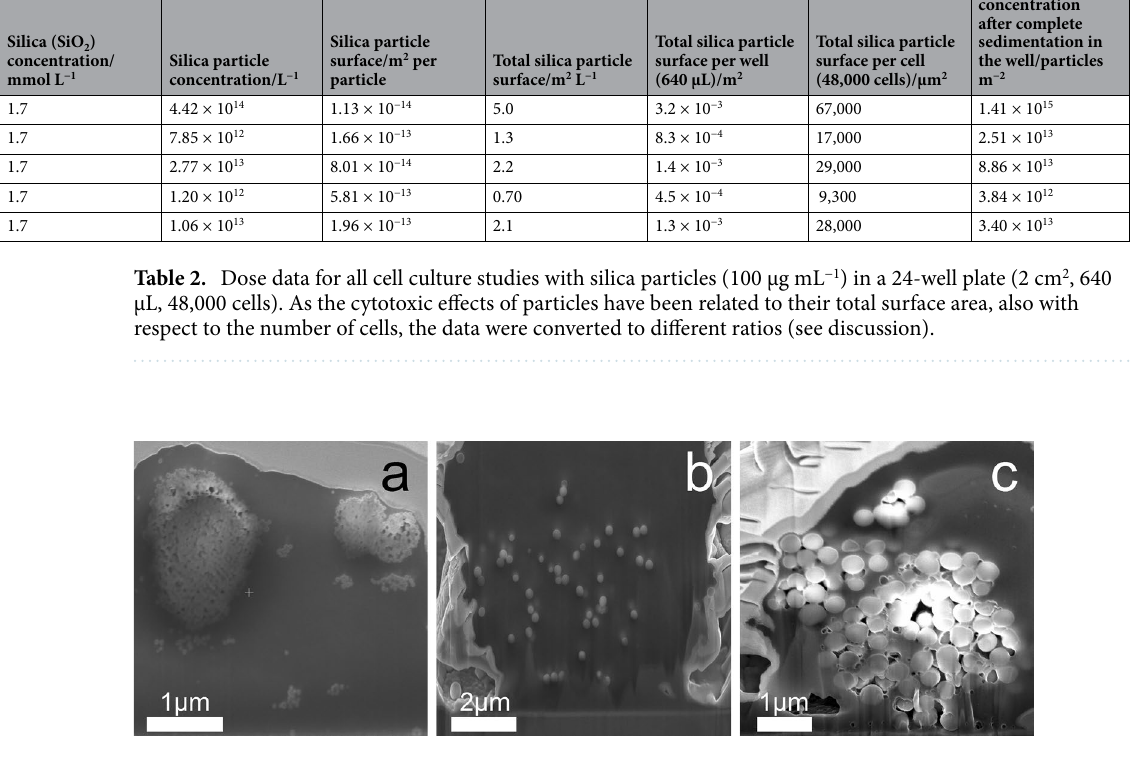
Figure 5. Representative SEM images of unfunctionalized silica particles in dissected (FIB milling) NR8383 alveolar macrophages after uptake (24 h; 100 µg mL −1 ): nanospheres ( a ), submicrospheres ( b ), microspheres ( c